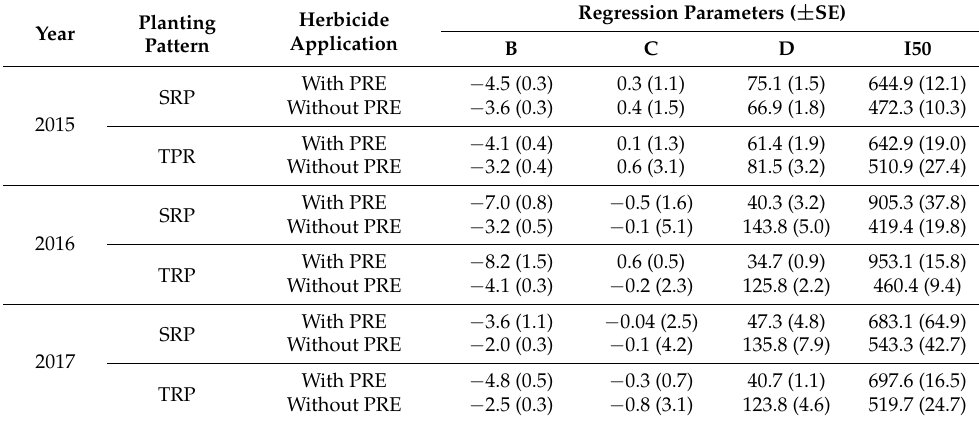
Table 4. Regression parameters showing the slope (B), lower limit (C), upper limit (D), and GDD at 50% reduction (I50) number of plants m − 2 (weeds) at two different planting patterns (standard and twin-row planting patterns) at two levels of herbicide application (with and without PRE herbicide) in corn in a field experiment conducted at Padina, Serbia, from 2015 to 2017. Herbicide